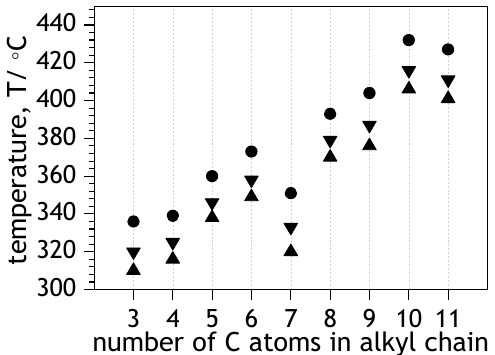
Figure 7. Thermal stability of the studied NDIs in the function of carbon atoms in alkyl chain. Symbols ▲ , ▼ and ● indicate 3%, 5%, and 10% weight loss: T − 3 , T − 5 , and T − 10 , respectively.